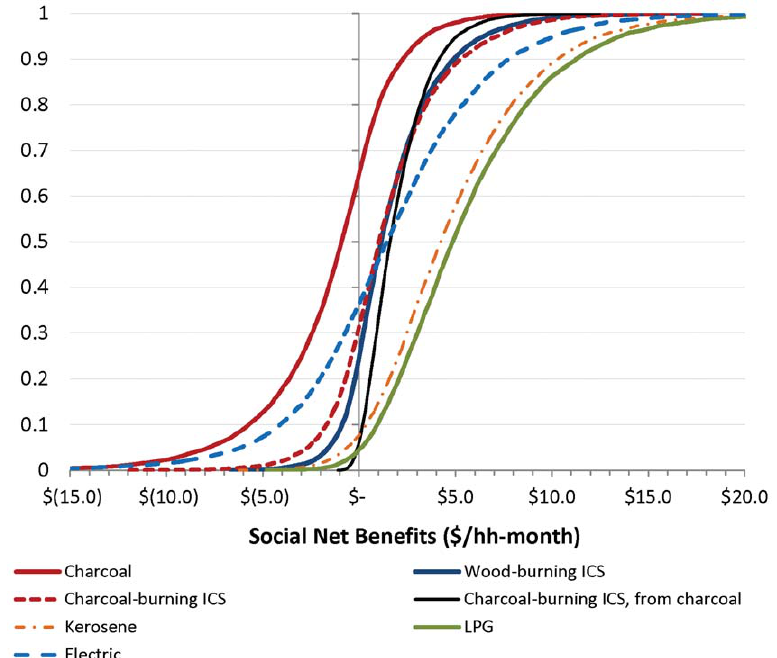
Figure 2. Social net benefits of different stove options, with UNFCC methodology accounting for emissions from CO 2 , CH 4 , and N 2 O. All are measured relative to traditional wood-burning stoves except for the move from the traditional to improved charcoal-burning stove.